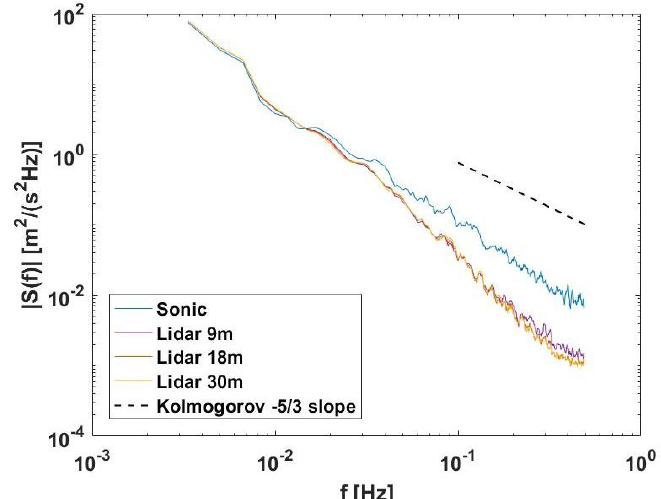
Figure 14. Power density spectra for the Lidar with different range gate lengths, the sonic anemometer and the theoretical Kolmogorov slope.